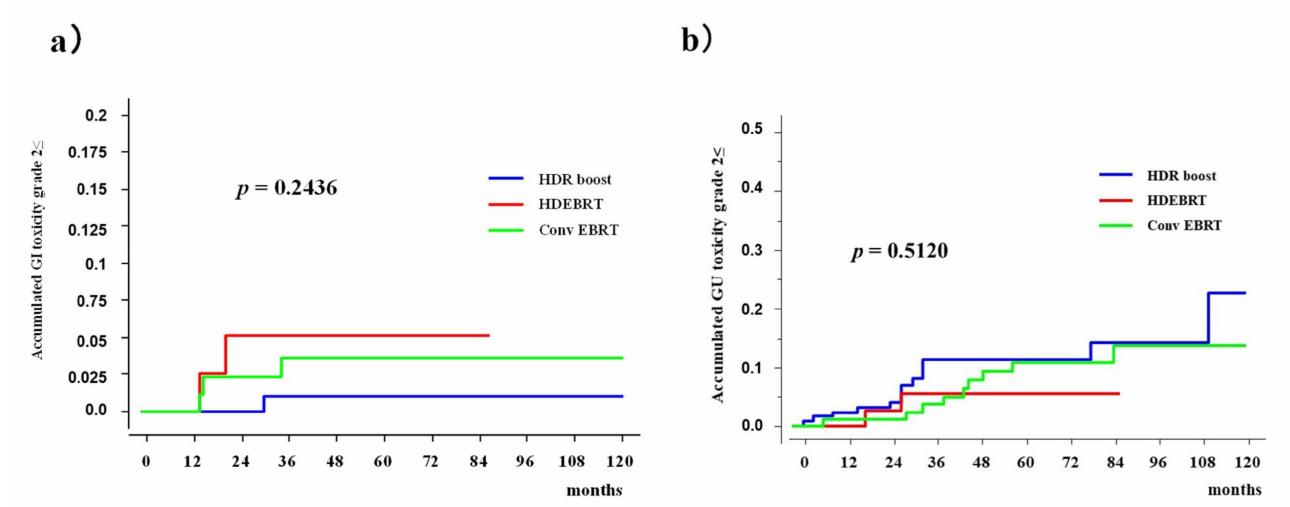
Figure 5. Accumulated incidence of grade ≥ 2 late toxicity among Conv EBRT, HDEBRT, and HDR boost groups. ( a ) Ac- cumulated incidence of grade ≥ 2 gastrointestinal (GI) toxicity. ( b ) Accumulated incidence of grade ≥ 2 genitourinary (GU)